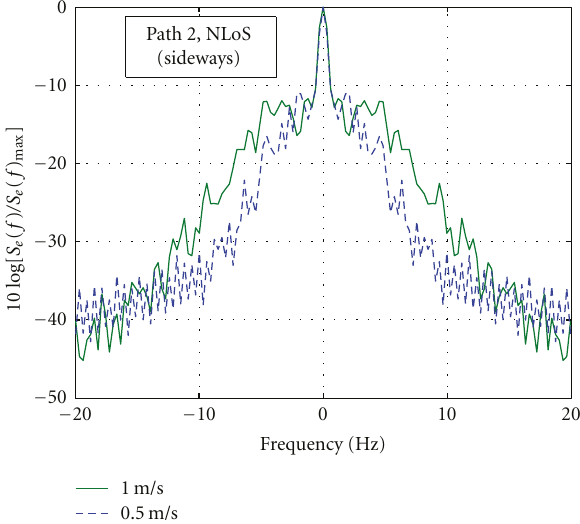
Figure 11: Power spectral density for the firefighter at varying speeds along path 3 (the hall, NLoS). The power densities of the four antennas are summed in the frequency domain.